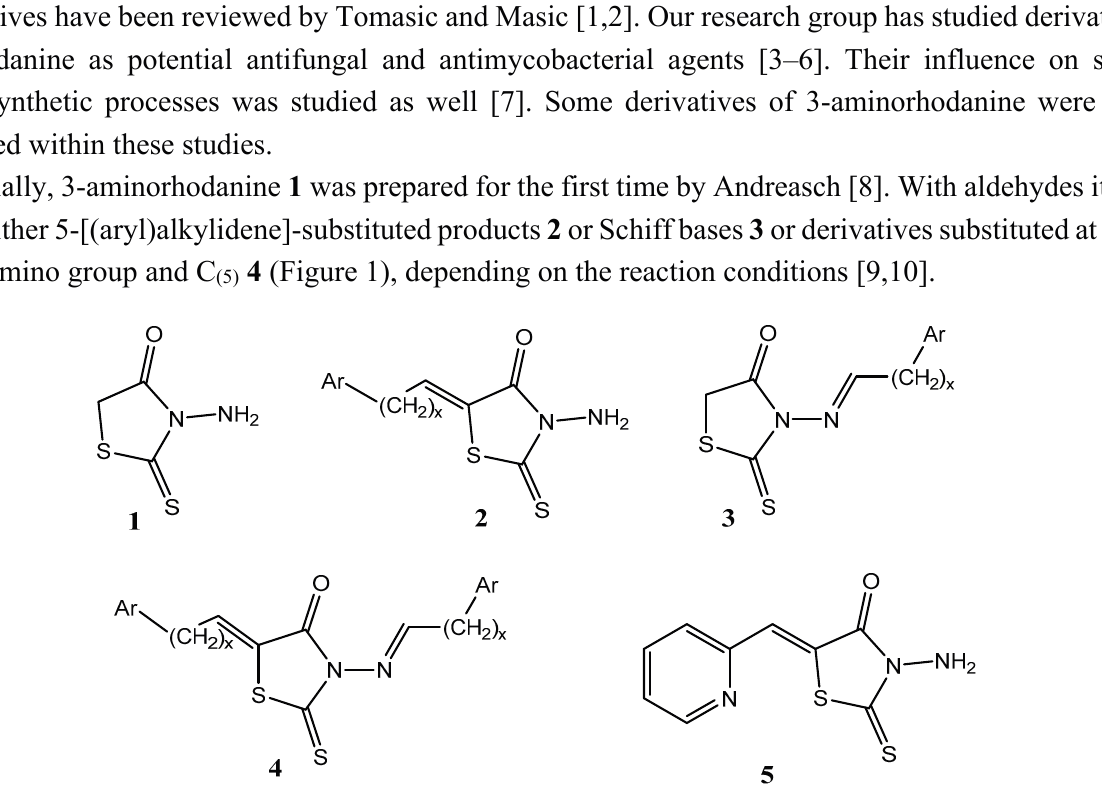
Figure 1. Graphic representation of 3-aminorhodanine and its condensation products with aldehydes. Stainier and Lapiere [9,10] used three different methods. When they performed condensation of equivalent amounts of 3-aminorhodanine 1 and an aldehyde in the presence of glacial acetic acid (method A) or in alcohol (method B), the derivative of the general formula 3 was obtained (Scheme 1).